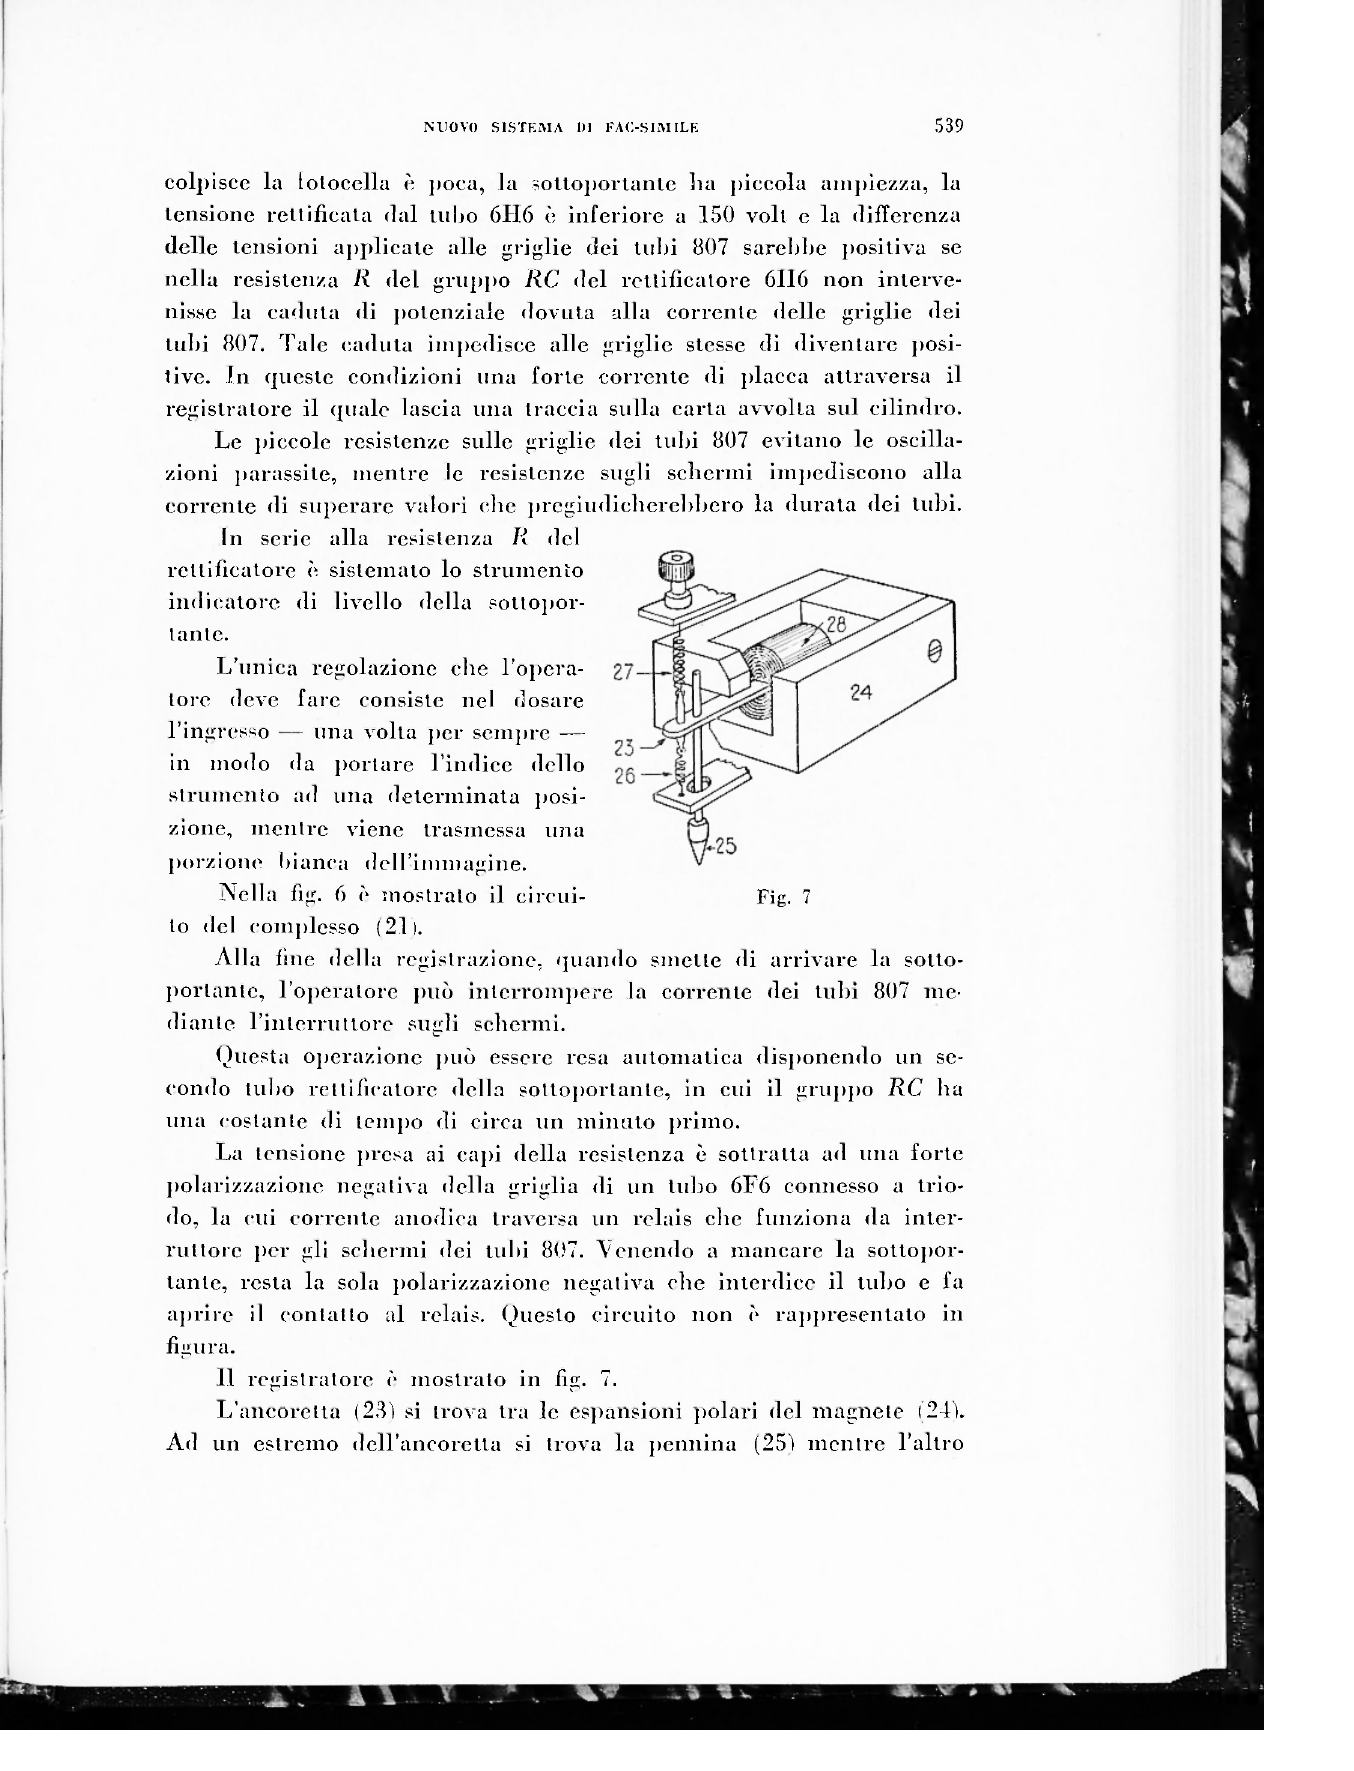
11 registratore è mostrato in fig. 7. L'ancoretta (23) si trova tra le espansioni polari del magnete (24). Ad un estremo dell'ancoretta si trova la pennina (25) mentre